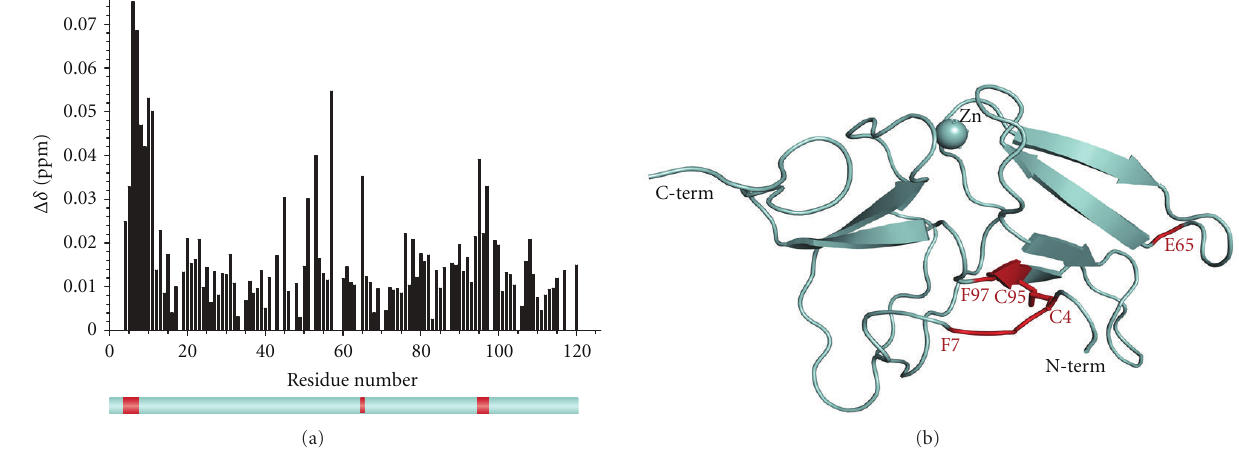
Figure 1: (a) Chemical shift di ff erence observed for each residue of MsrB1 upon NMR titration by Trx. Lower panel shows in red the residues belonging to the protein active site revealing maximal changes upon titration. (b) The 3D structure of oxidized mammalian MsrB1. “Hot points” used for molecular docking are evidenced in red.